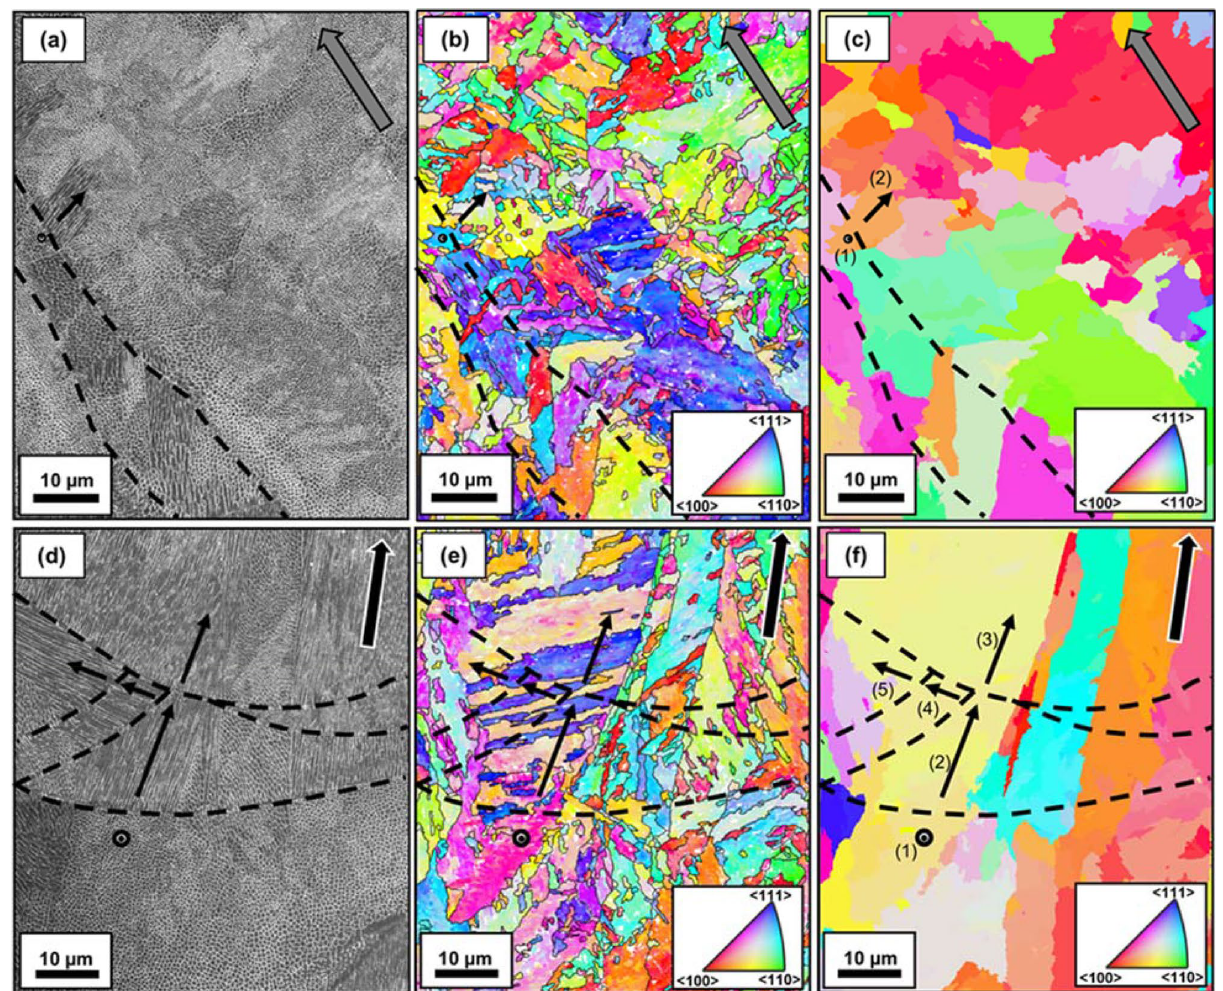
Figure 7. Correlative ( a , d ) SEM ( b , c , e , f ) EBSD results corresponding to the transverse ( a – c ) and longitudinal ( d – f ) sections of the EOS condition—40 μm—CW laser, where the SD and the BD are indicated by a grey and a black arrow, respectively, and where the EBSD orientations are colored according to their IPF—BD color. The EBSD data correspond to ( b , e ) the bcc phase and ( c , f ) the corresponding reconstructed prior fcc phase. The dashed black lines represent the MP boundary and the arrows represent the different colony growth directions in given prior fcc grain. Each of the arrows is identified by an